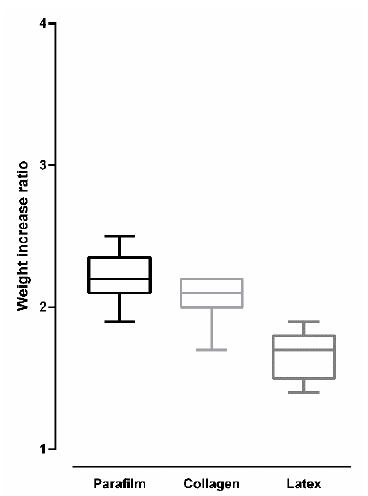
Figure 9. Weight-increase ratio after Culex quinquefasciatus females were artificially blood-fed using different membranes (bars = ±SEM).